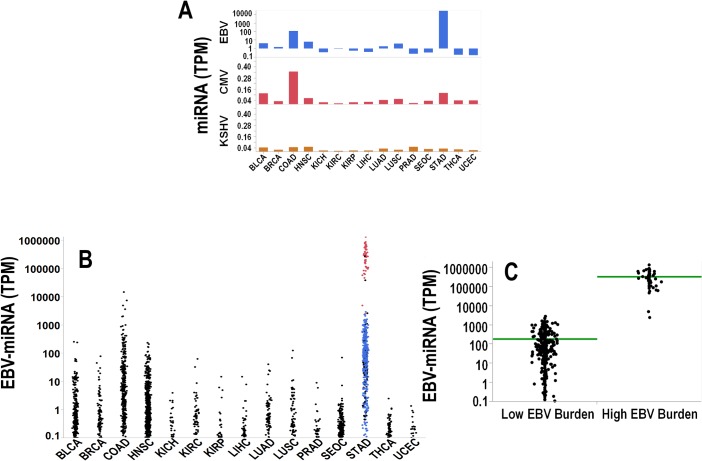
A: Bar charts showing the average viral miRNA expression in cancer tissues grouped by virus species. From top to bottom: EBV, CMV and KSHV. Legends of the x-axis are taken from TCGA nomenclature and are as follows: Bladder Carcinoma (BLCA), Breast Cancer (BRCA), Colon Adenocarcinoma (COAD), Head & Neck Squamous Carcinoma (HNSC), Chromophobe Renal Cell Carcinoma (KICH), Renal Clear Cell Carcinoma (KIRC), Renal Papillary Cell Carcinoma (KIRP), Liver Hepatocellular Carcinoma (LIHC), Lung Adenocarcinoma (LUAD), Lung Squamous Cell Carcinoma (LUSC), Prostate Adenocarcinoma (PRAD), Serous Ovarian Cancer (SEOC), Stomach Adenocarcinoma (STAD), Papillary Thyroid Carcinoma (THCA), and Uterine Corpus Endometrial Carcinoma (UCEC). B: Dot plots depicting the expression of EBV-miRNAs across all the tumor types as labeled in A. In color the samples overlapping with the TCGA study [15] are depicted. Samples in blue and red are classified in [15] as low and high EBV burden, respectively. In C the difference in the expression for samples at high/low EBV burden is significant (p<0.001).